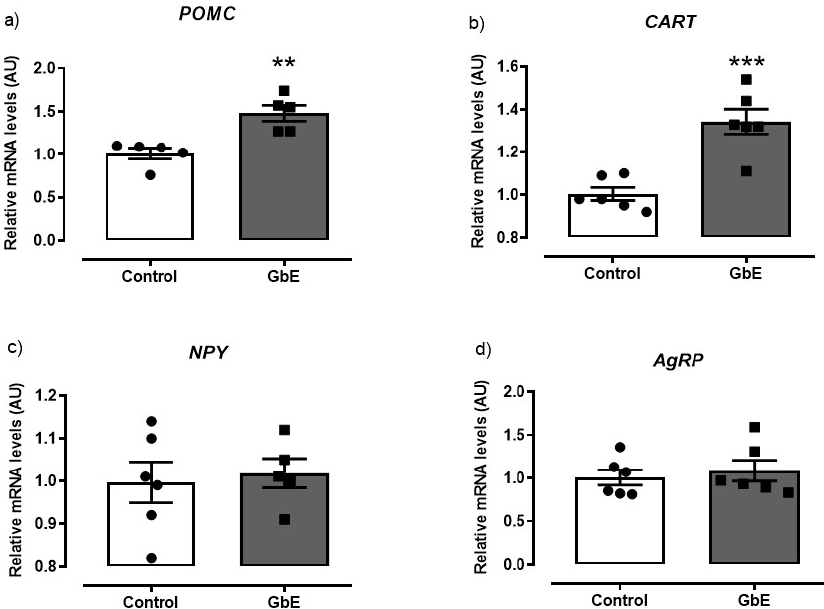
Figure 1. Relative mRNA levels of the hypothalamic neuropeptides: POMC ( a ), CART ( b ), NPY ( c ), and AgRP ( d ) of Control ( n = 5–6) and Ginkgo biloba (GbE; n = 5–6) groups analyzed by RT-qPCR. ** p < 0.01, *** p < 0.001.